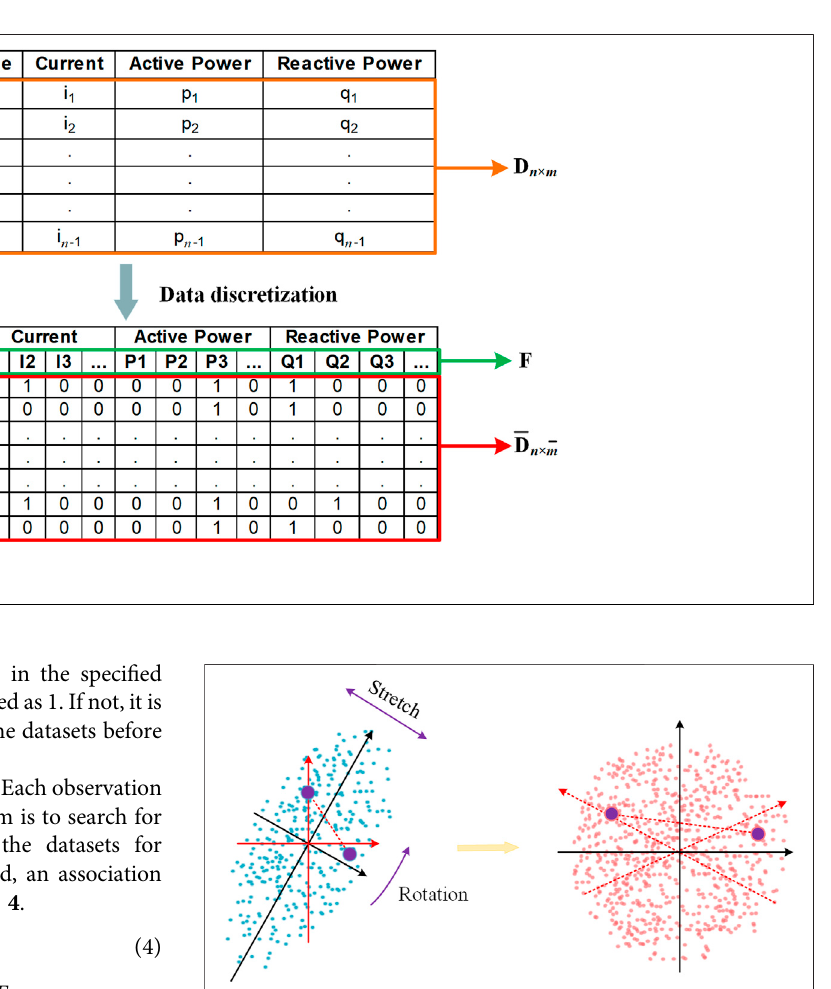
FIGURE 5 | An illustration of Mahalanobis